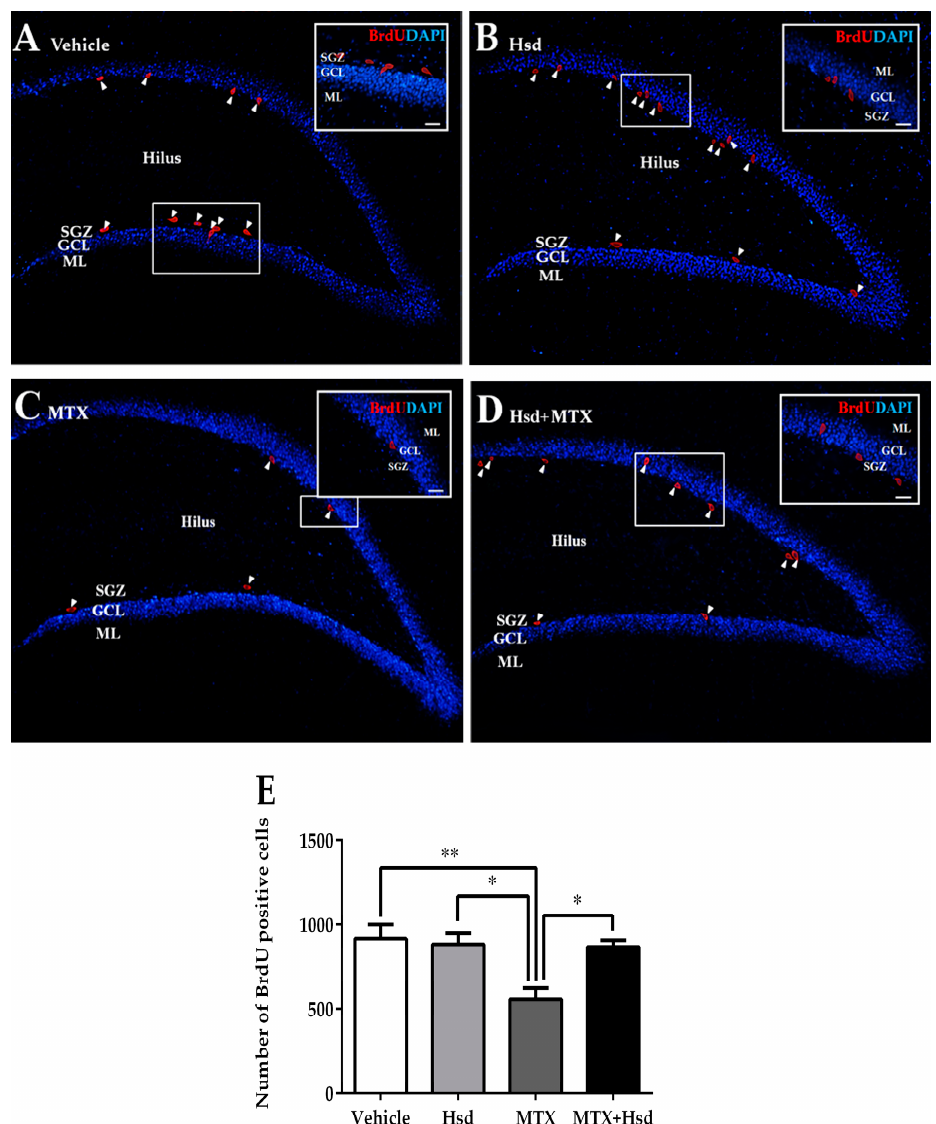
Figure 6. BrdU positive cells (red) in the SGZ of the DG in the hippocampus in the vehicle group ( A ), Hsd group ( B ), MTX group ( C ), and MTX + Hsd ( D ) group. The data shows a significant decline in cell survival in the MTX group in comparison with the vehicle, Hsd, and MTX + Hsd groups (Data are displayed as mean ± S.E.M. * p < 0.05; ** p < 0.01 significantly different from the MTX group) ( E ). SGZ: subgranular zone; GCL: granule cell layer; ML: molecular layer.